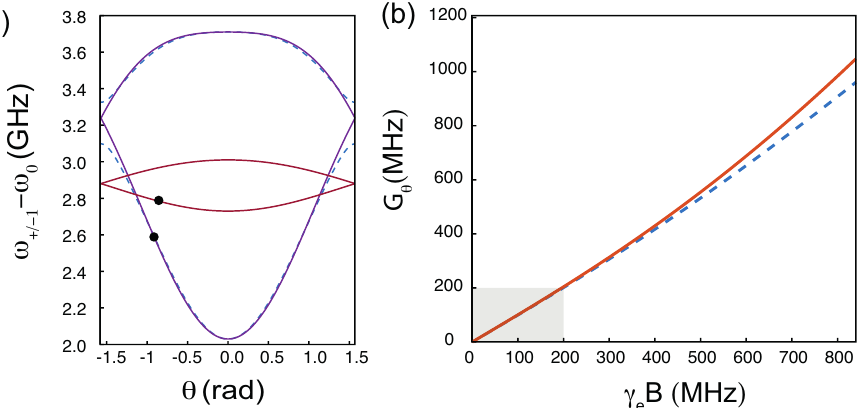
Figure 4. ( a ) Electronic spin transition energies of the NV − center as a function of the angle θ for magnetic fields of 50 G (brown lines) and 300 G (blue lines). The black dots indicate the optimum angles for the largest spin-torques. ( b ) Optimum coupling strength G θ on the | 0 (cid:105) to |− 1 (cid:105) transition as a function of the external magnetic field. The shaded area corresponds to the magnetic field values for which the optimized coupling strength is very close to γ e B . In both plots, numerical calculations without approximations are shown by dashed